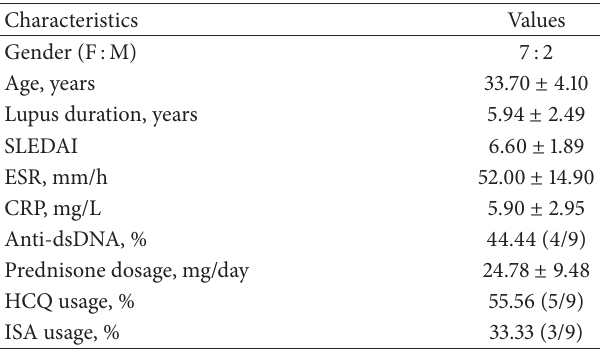
Table 1: Clinical and laboratory features in 9 patients with systemic lupus erythematosus